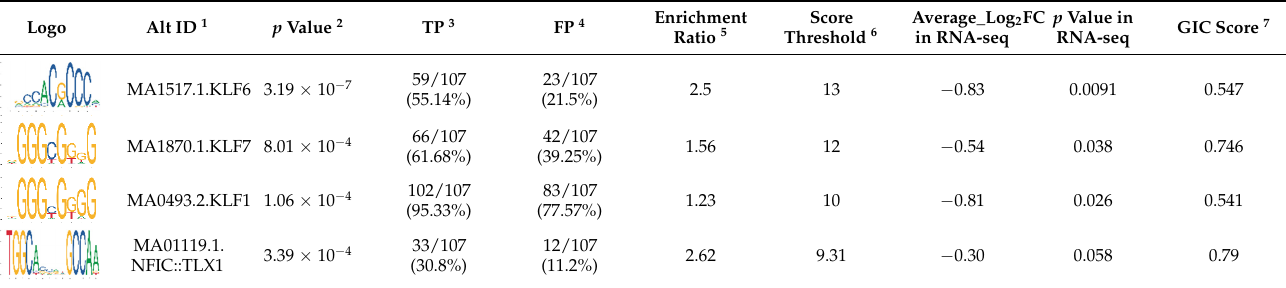
Table 2. Binding motif and GIC analysis of four transcription factors.